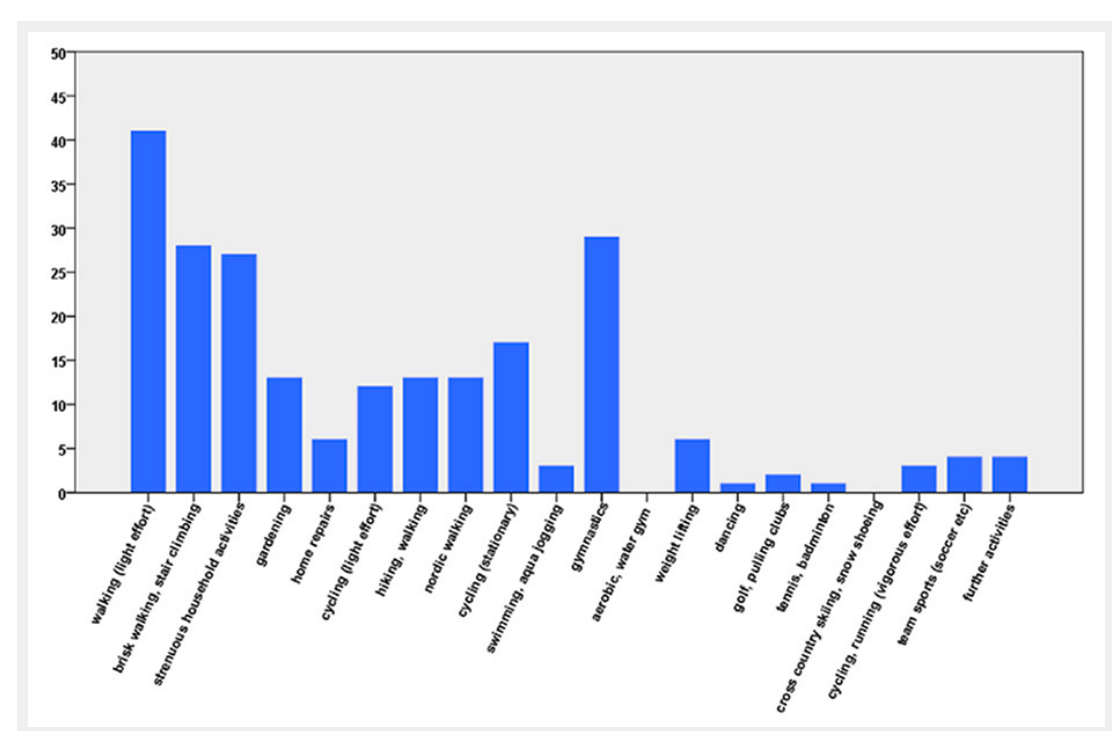
Figure 1 Number of patients who performed the physical activities in a typical week during the previous 2 months; data from questionnaire 1 (n =